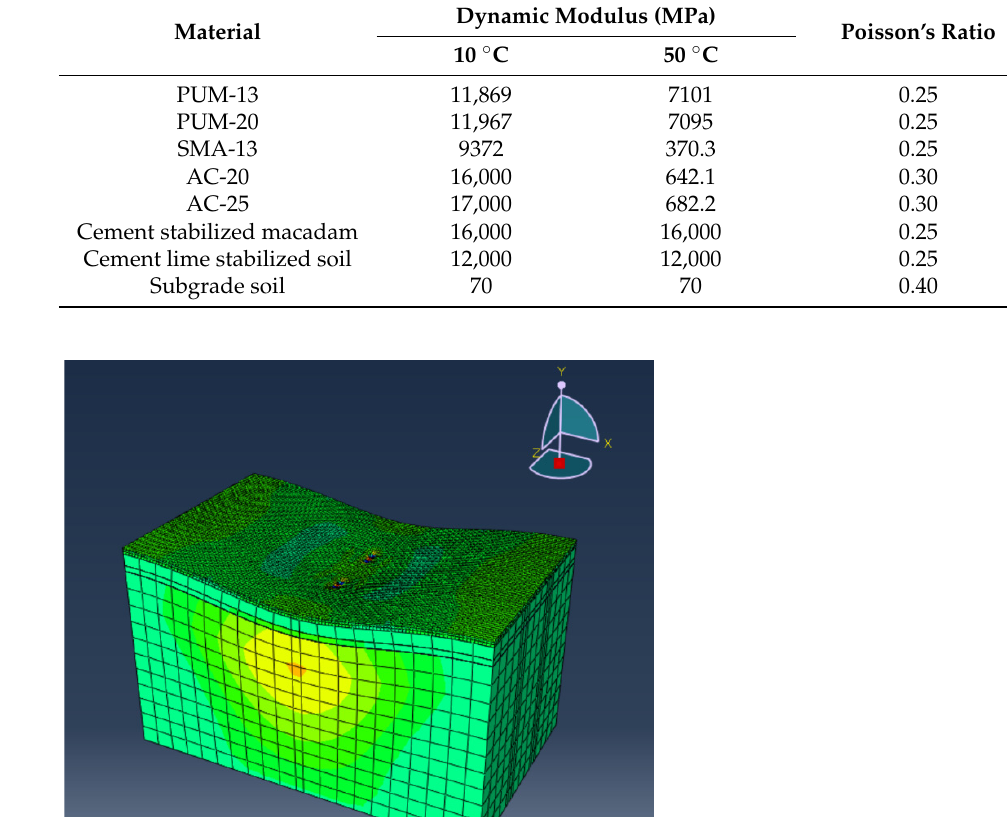
Table 4. Material parameters of each structural layer.